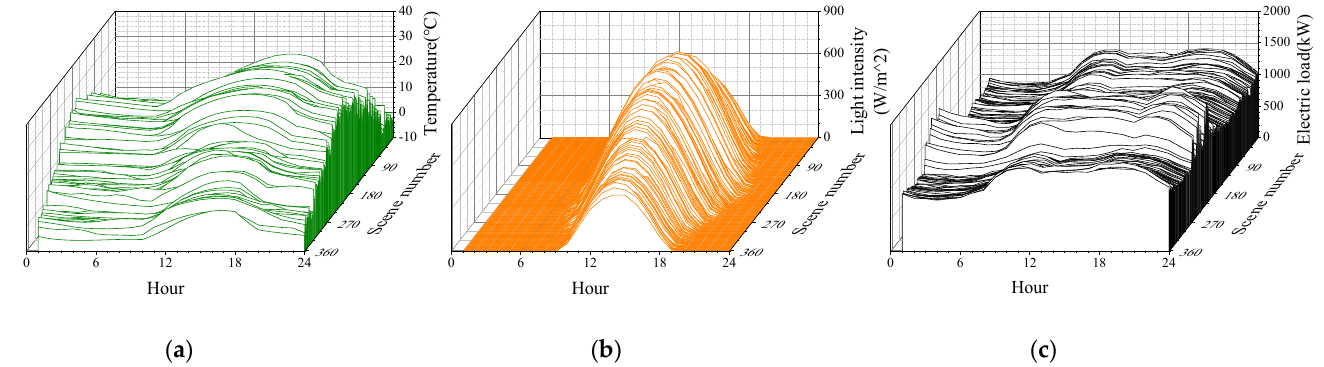
Figure 2. ( a ) Hourly data of temperature; ( b ) Hourly data of light intensity; ( c ) Hourly data of load. It can be seen from Figure 2 that temperature, light intensity, and load have obvious time series characteristics, and their values change regularly with the change of seasons and moments. This means that a small number of typical scenes that can reflect the characteristics and laws of the overall data through scene clustering can be found. Using the improved FCM algorithm proposed in this paper, the three types of data shown in Figure 2 are clustered separately, and the clustering results obtained are shown in Figure 3.